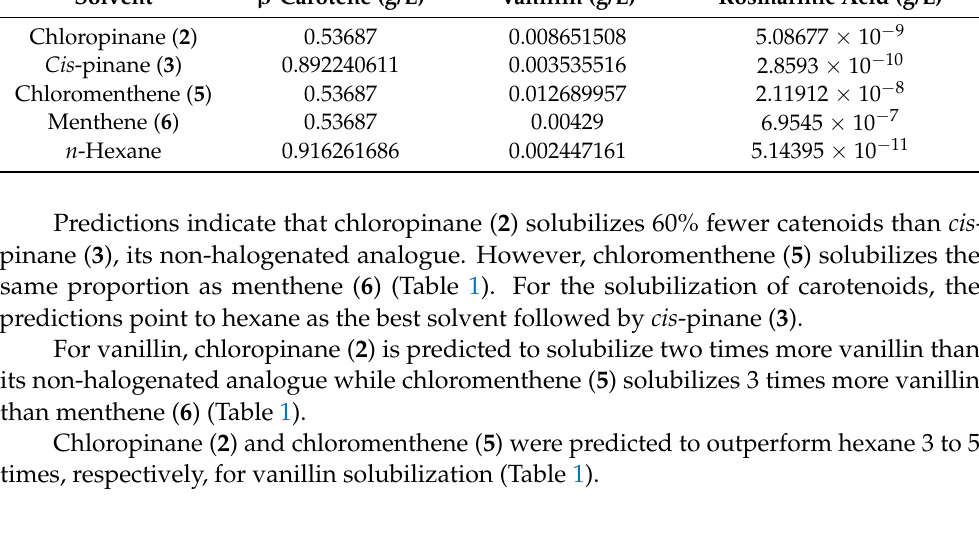
Table 1. Solubility prediction of β -carotenoids, vanillin, and rosmarinic acid. Solvent β -Carotene